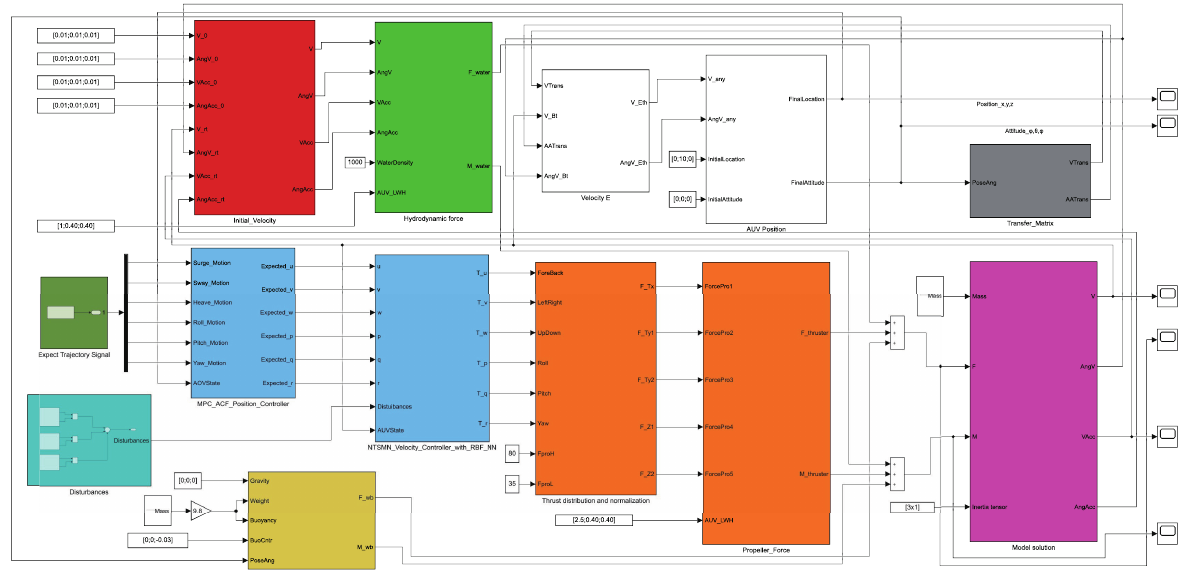
Figure 8. Simulation